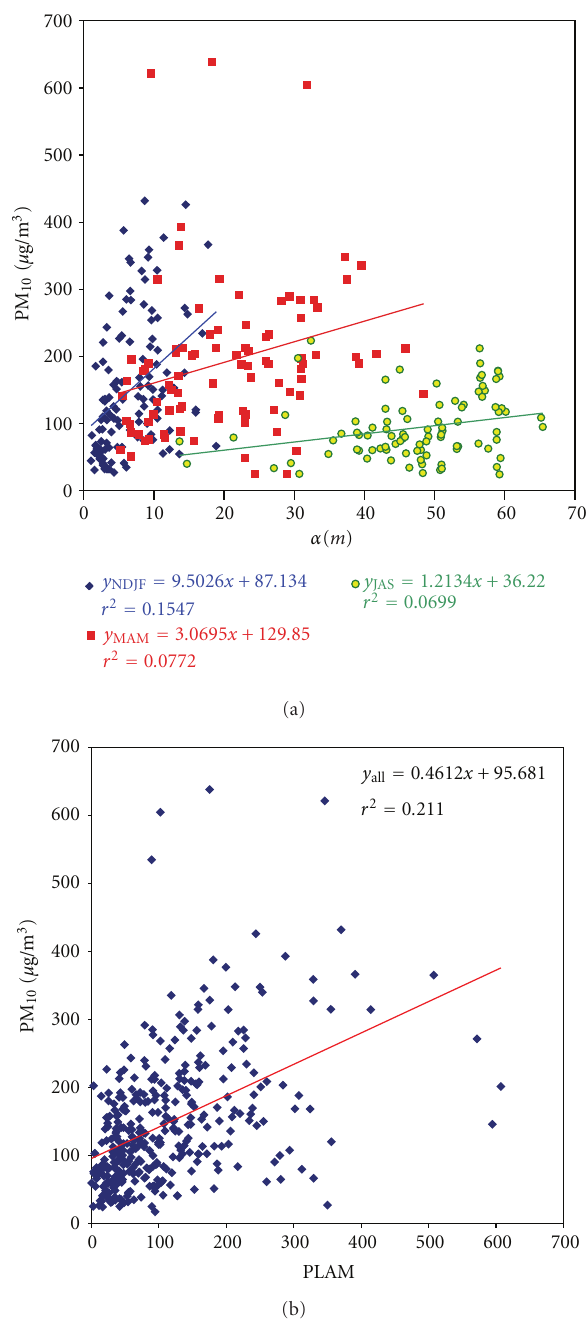
Figure 3: Correlations of α ( m ) and PLAM with PM 10 observations for a